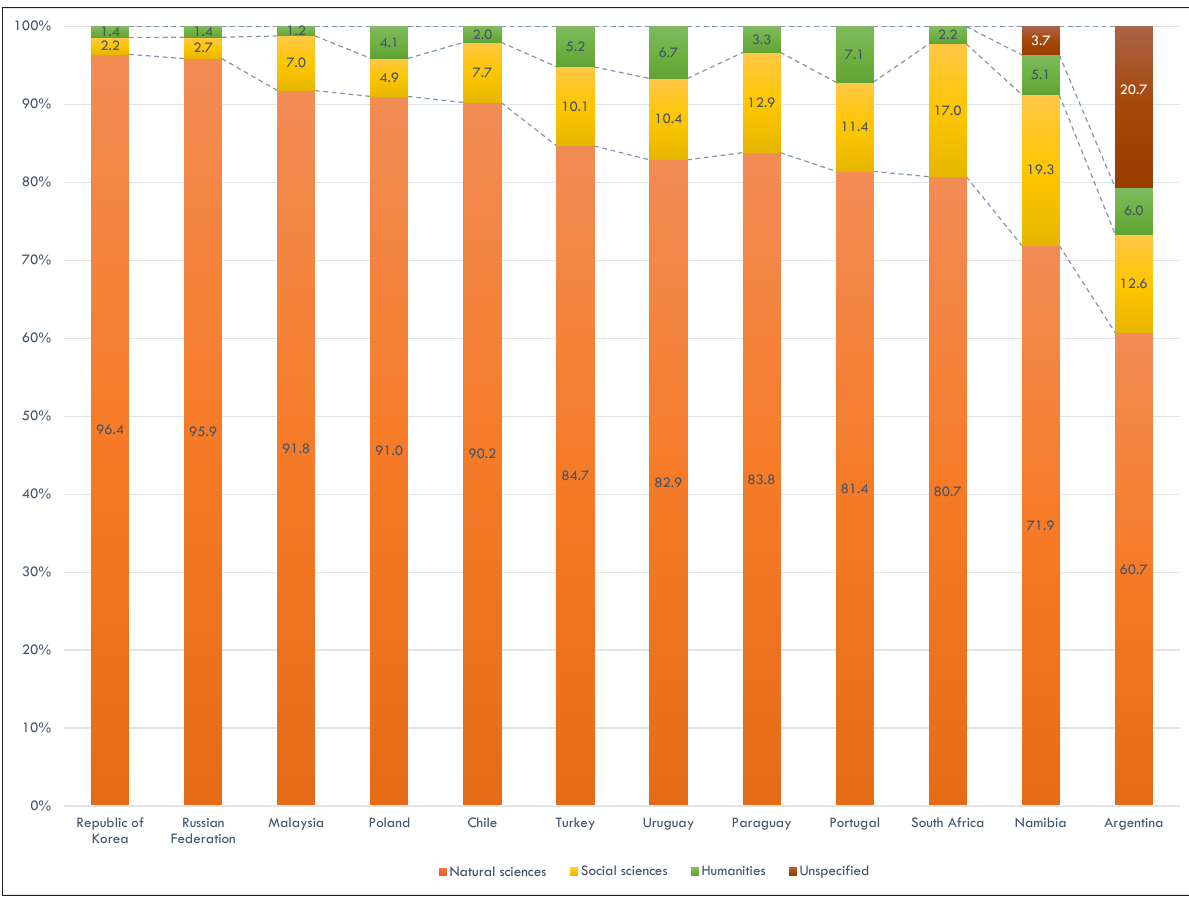
Data are for 2014 or the closest available year as indicated in brackets. The heading ‘natural sciences’ includes the following sub-categories: engineering and technology, natural sciences, medical and health sciences, and agricultural and veterinary sciences. Figure 2: International comparison of R&D expenditure by research field as a % of GERD,